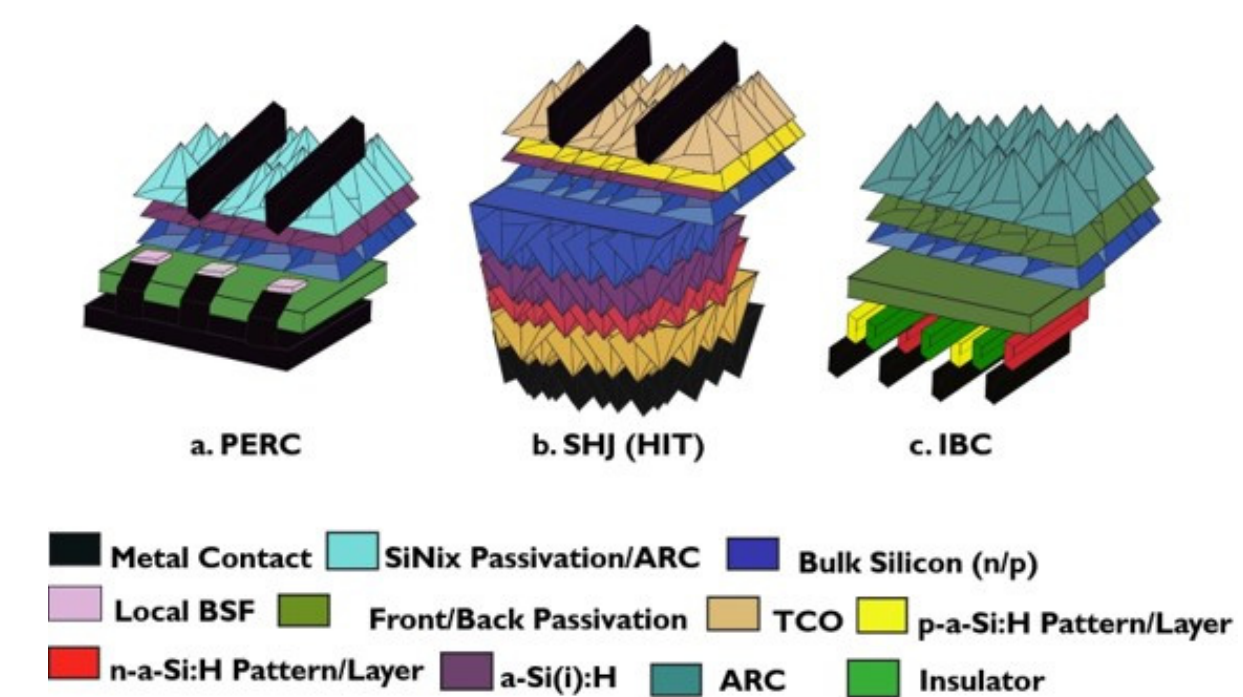
Figure 5. Generic and fragmented silicon solar cell technologies cross-section schematics (The surface morphology may vary from flat surface/partially textured to the fully textured surface) From Left to right ( a ) PERC technology, middle ( b ) SHJ technology and ( c ) IBC. All structures and materials are for an explanatory purpose reprinted from [186], Copyright (2016), with permission from Elsevier (Not to Scale). (Note: in PERC structure, back metal contact in the black color is intended to diffuse through insulator via local BSF layer).